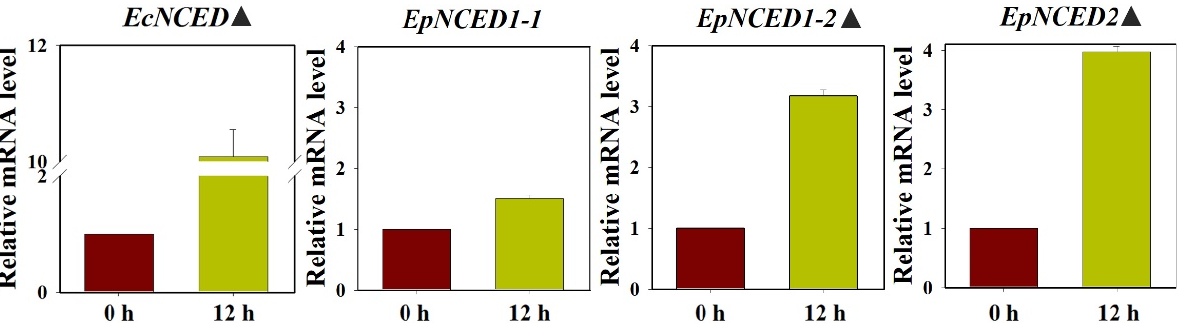
Figure 6. NCED gene expression patterns in barnyardgrass ( EcNCED ) and yerbadetajo ( EpNCED ) after florpyrauxifen ‐ benzoyl treatment. The X ‐ axis represents the time after florpyrauxifen ‐ benzoyl treatment. The Y ‐ axis represents transcript levels relative to 0 h untreated with florpyrauxifen ‐ benzoyl. Data are the mean values of six technical and biological replicates. The standard errors of the means are described by vertical bars. The icon “ ▲ ” represents genes that were up ‐ regulated more than 2 fold by florpyrauxifen ‐ benzoyl and significant high than the untreated control group (0 h).